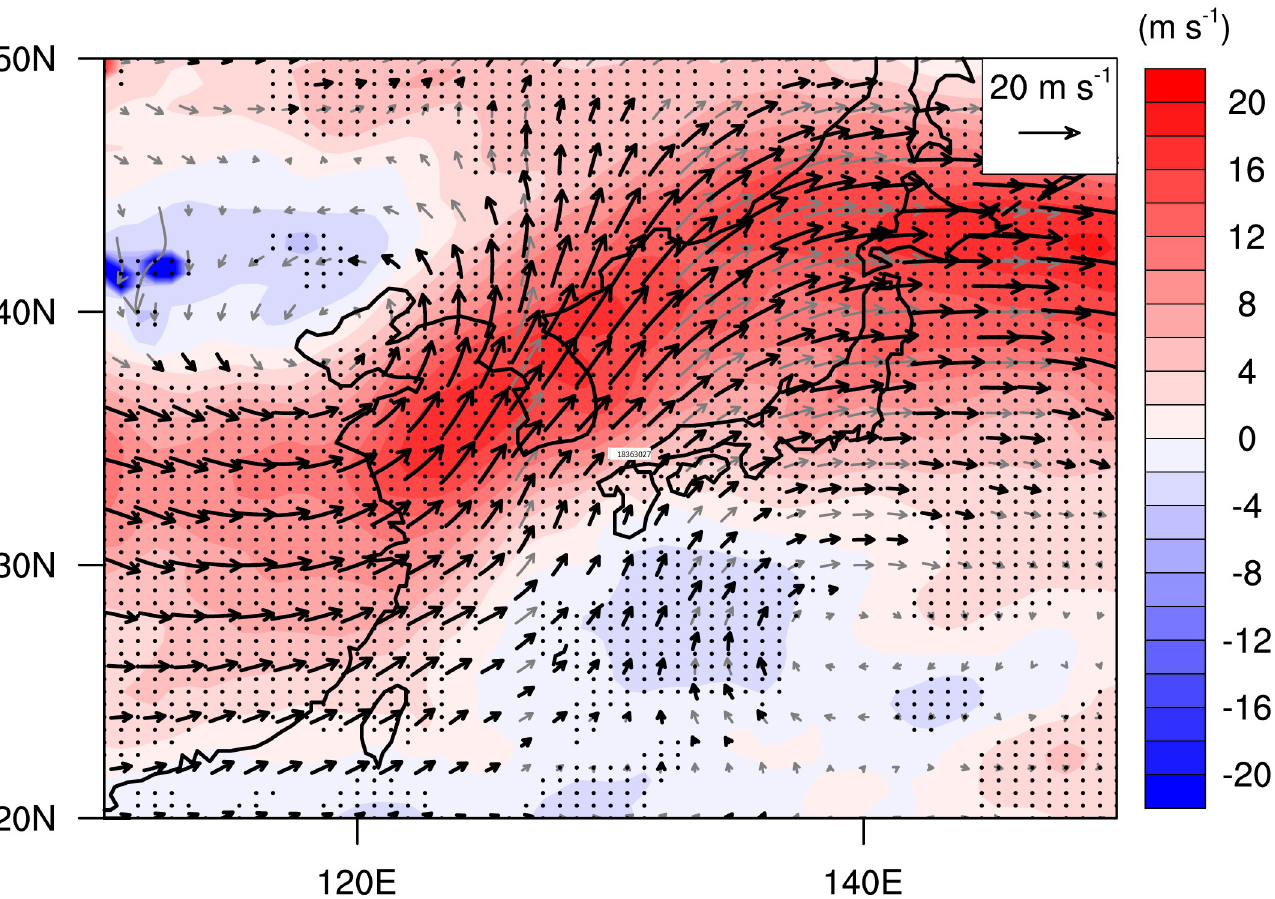
Fig 9. The difference composite (SS minus WS) of vertical wind shear (arrows, unit: m s -1 ) and its magnitude (shaded, unit: m s -1 ) between 850 and 250 hPa level. The thick black arrows and gray dots indicate the statistically significant differences at the 95% confidence level evaluated with Student’s t